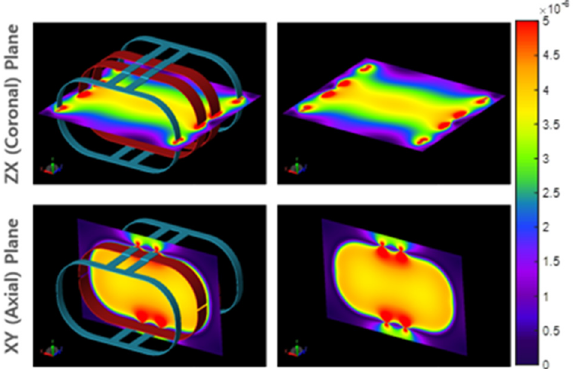
Figure 4. Circularly polarized (CP) excitation magnetic field (B 1 in Tesla) of the body RF coil model under the unloaded condition.